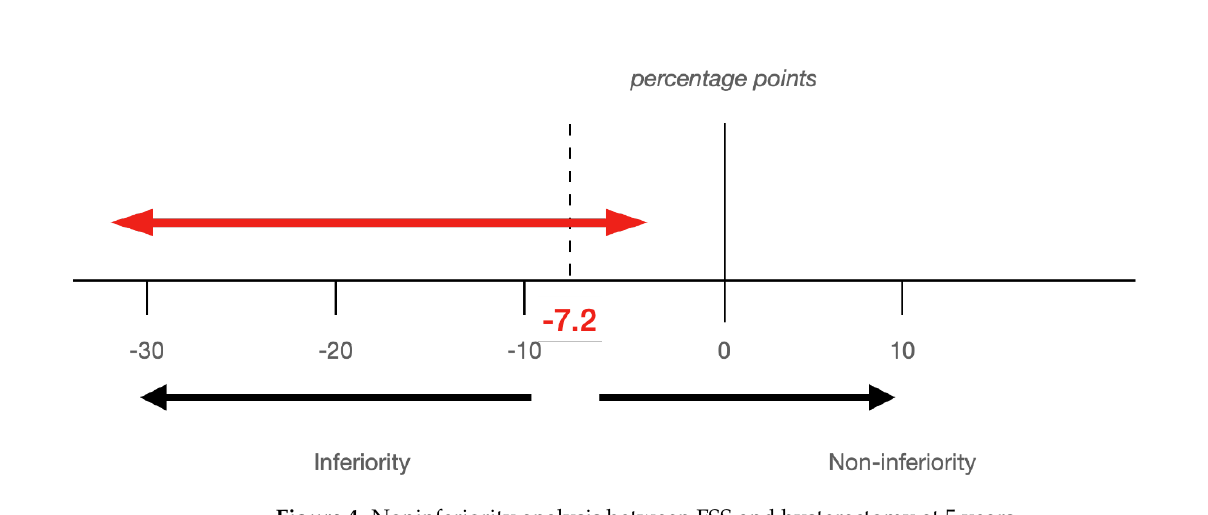
Figure 4. Noninferiority analysis between FSS and hysterectomy at 5 years.